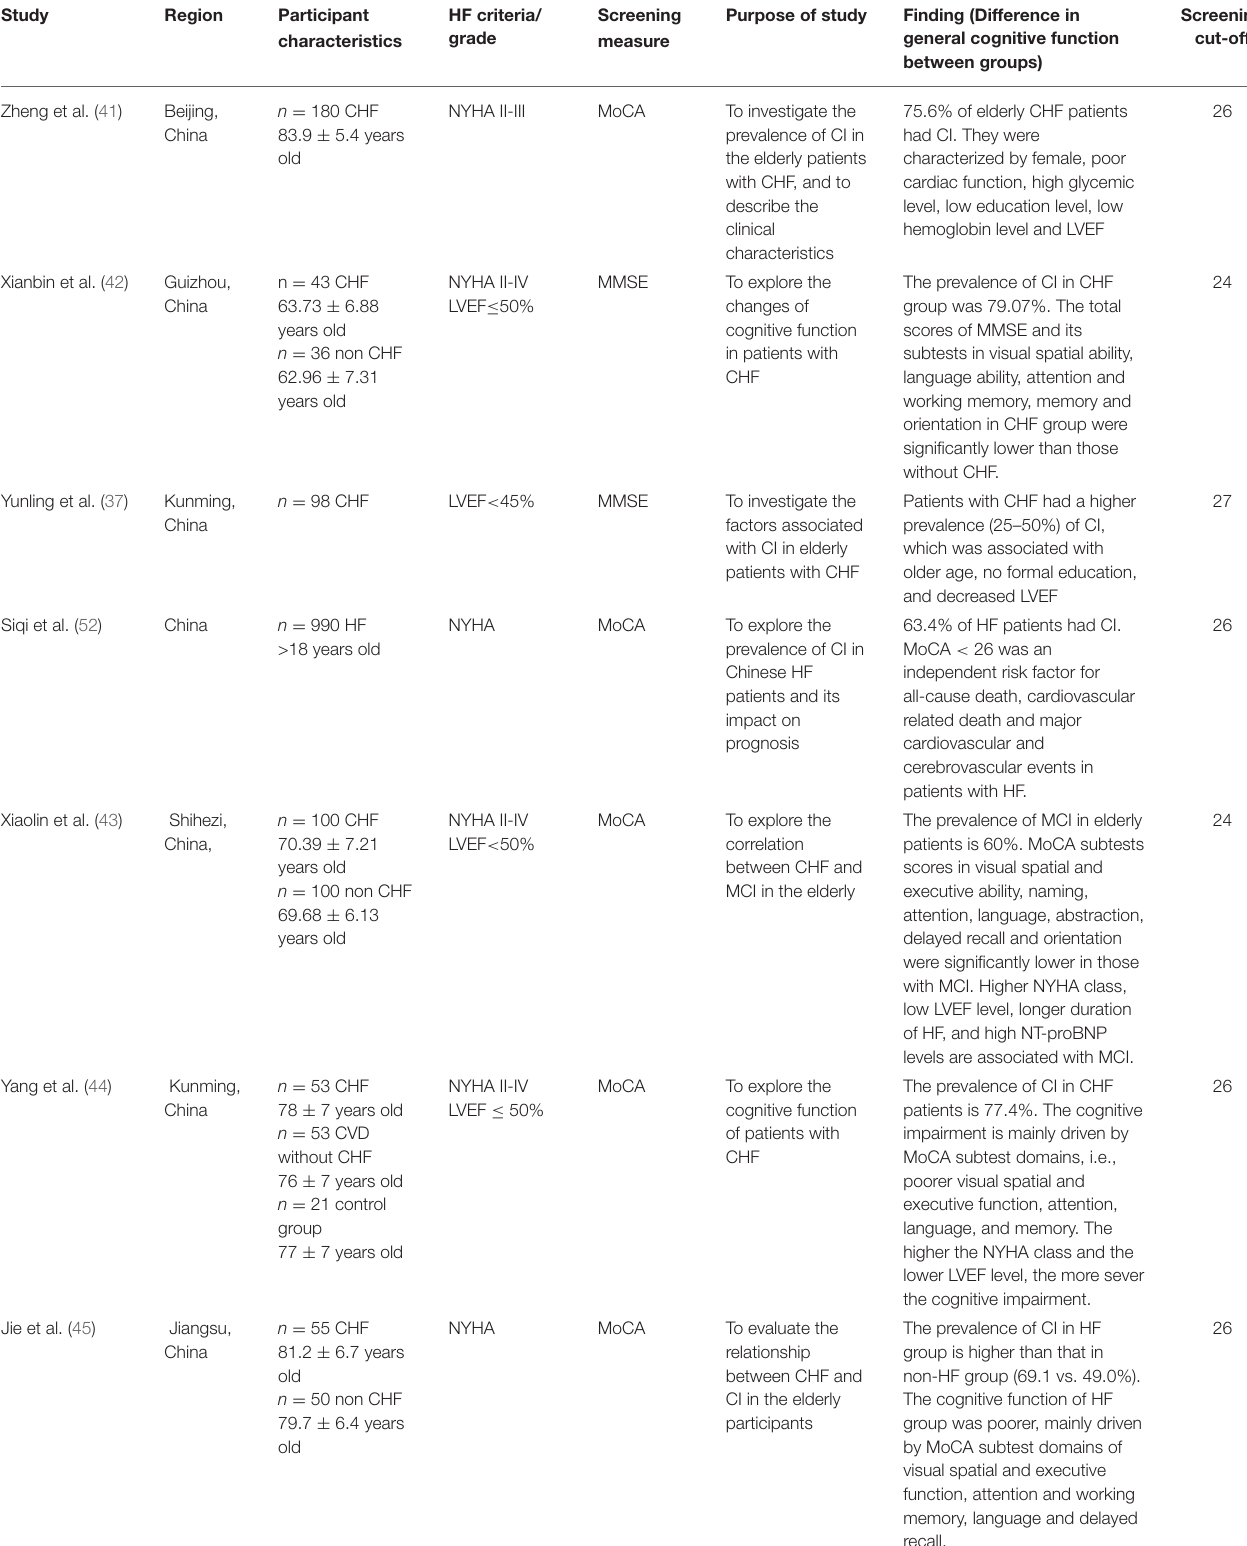
TABLE 2 | Summary of publications meeting the inclusion criteria of this systematic